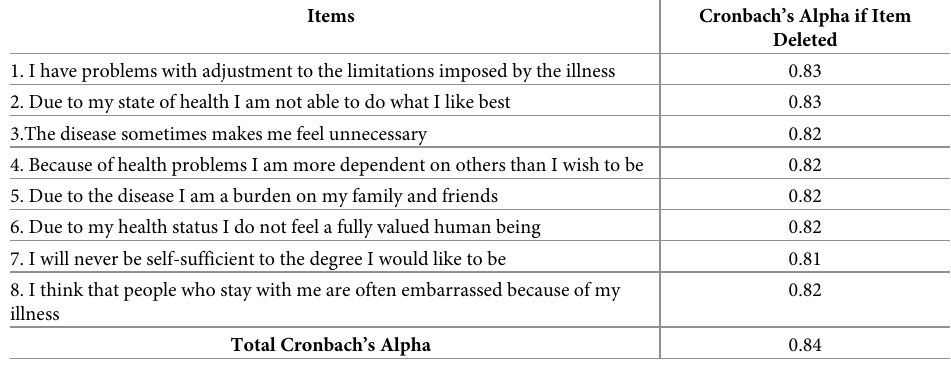
Table 5. Cronbach’s alpha values by item deletion for the translated Acceptance of Illness